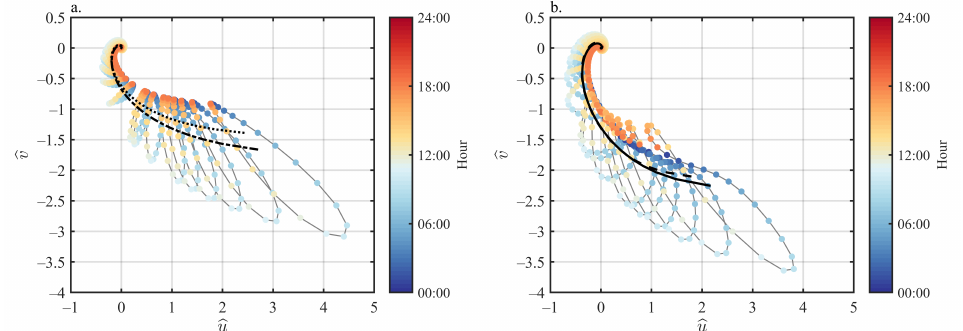
Figure 5. Diurnal cycle velocity in the Ekman model without CSF ( left ) and with CSF ( right ) under a steady wind stress, assuming δ = 0.6 and latitude at 45° N. Plotted for selected depths (thin grey lines) with a color scale indicating the hour of the day. The time-averaged diurnal velocity is shown (dotted-dashed black line in ( a ), solid black line in ( b ), as the steady-state solution (dotted black line in ( a ), dashed black line in ( b ). All the velocities are normalized by | τ a | A 0 = max ( A ( z ))